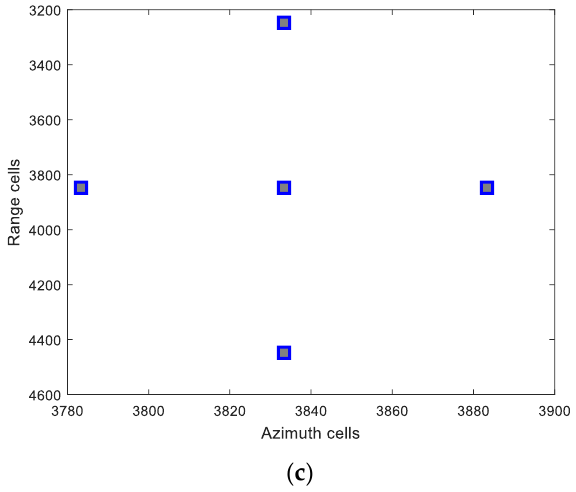
Figure 10. Positions of the point targets for different regions: ( a ) positions of the point targets in the unambiguous region; ( b ) positions of the point targets in the 1 t h ambiguous region; ( c ) positions of the point targets in the 2nd ambiguous region.